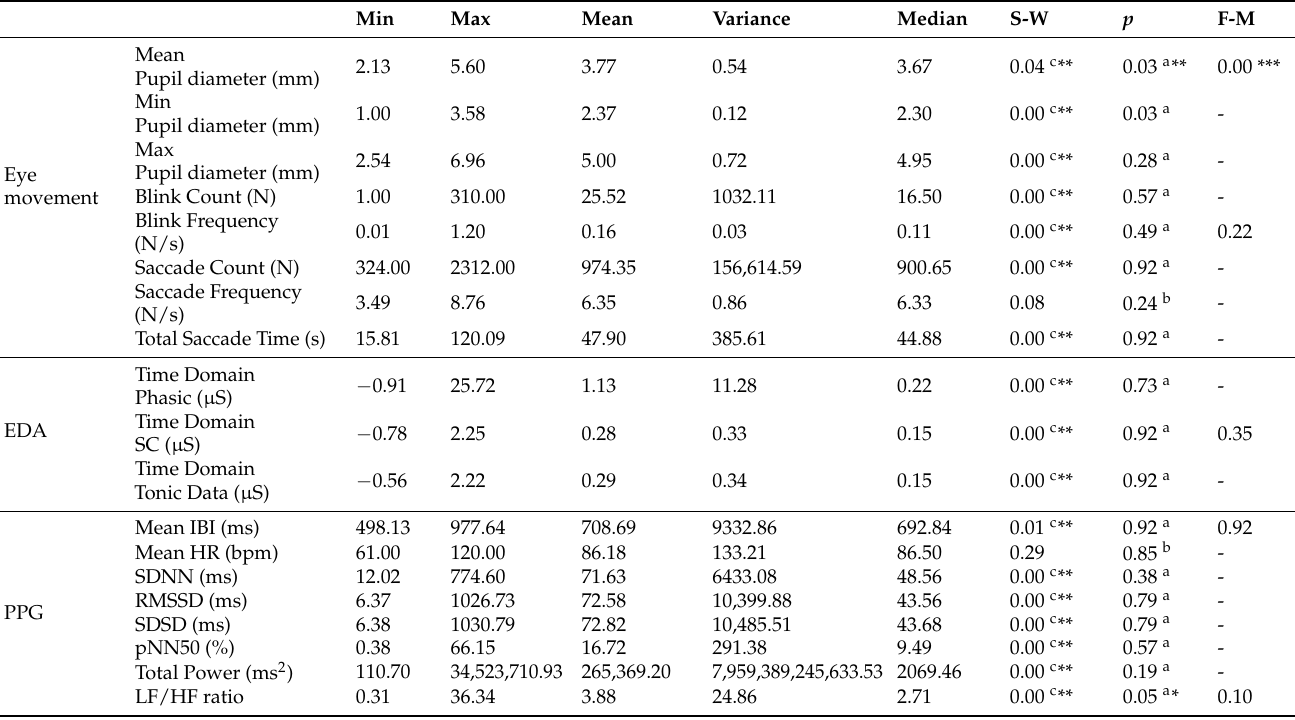
Table 1. Psychophysiology variables from all devices and